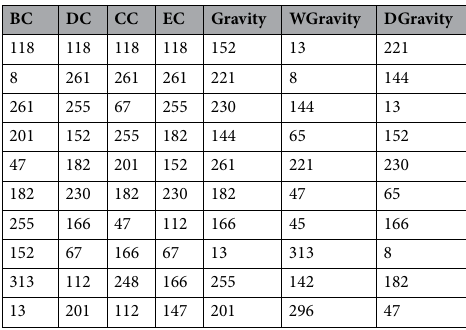
Table 4. The top 10 important nodes in USAir.